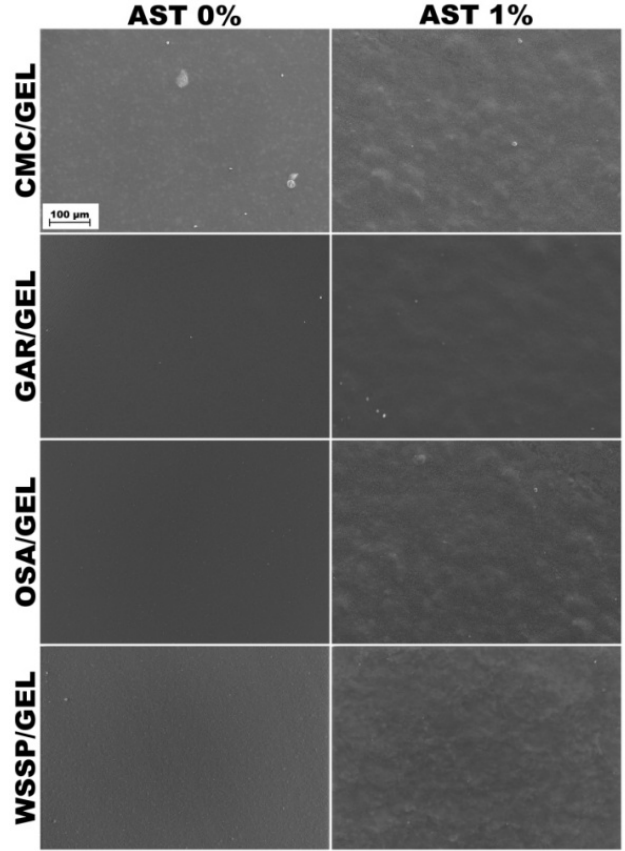
Figure 1. SEM images of the surfaces of the AST-free and 1%AST-added binary blend films based on polysaccharides (CMC, GAR, OSA and WSSP) and gelatin (GEL). Table 2. Film thickness and the quarter-release times (t 25% ) obtained from the best fitting mathemati- cal